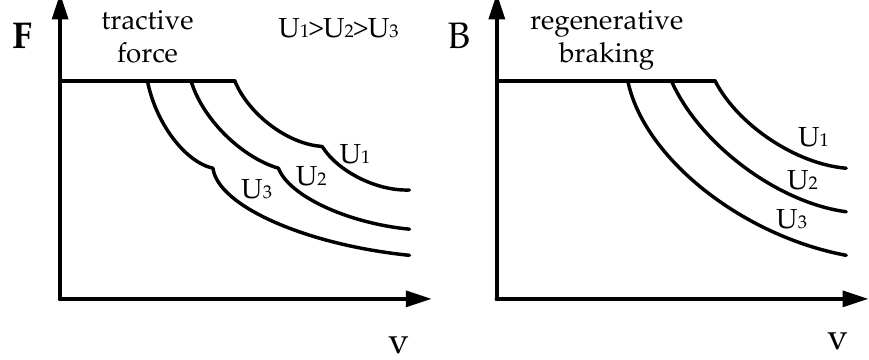
Figure 2. Tractive and regenerative braking curve under different net voltages.